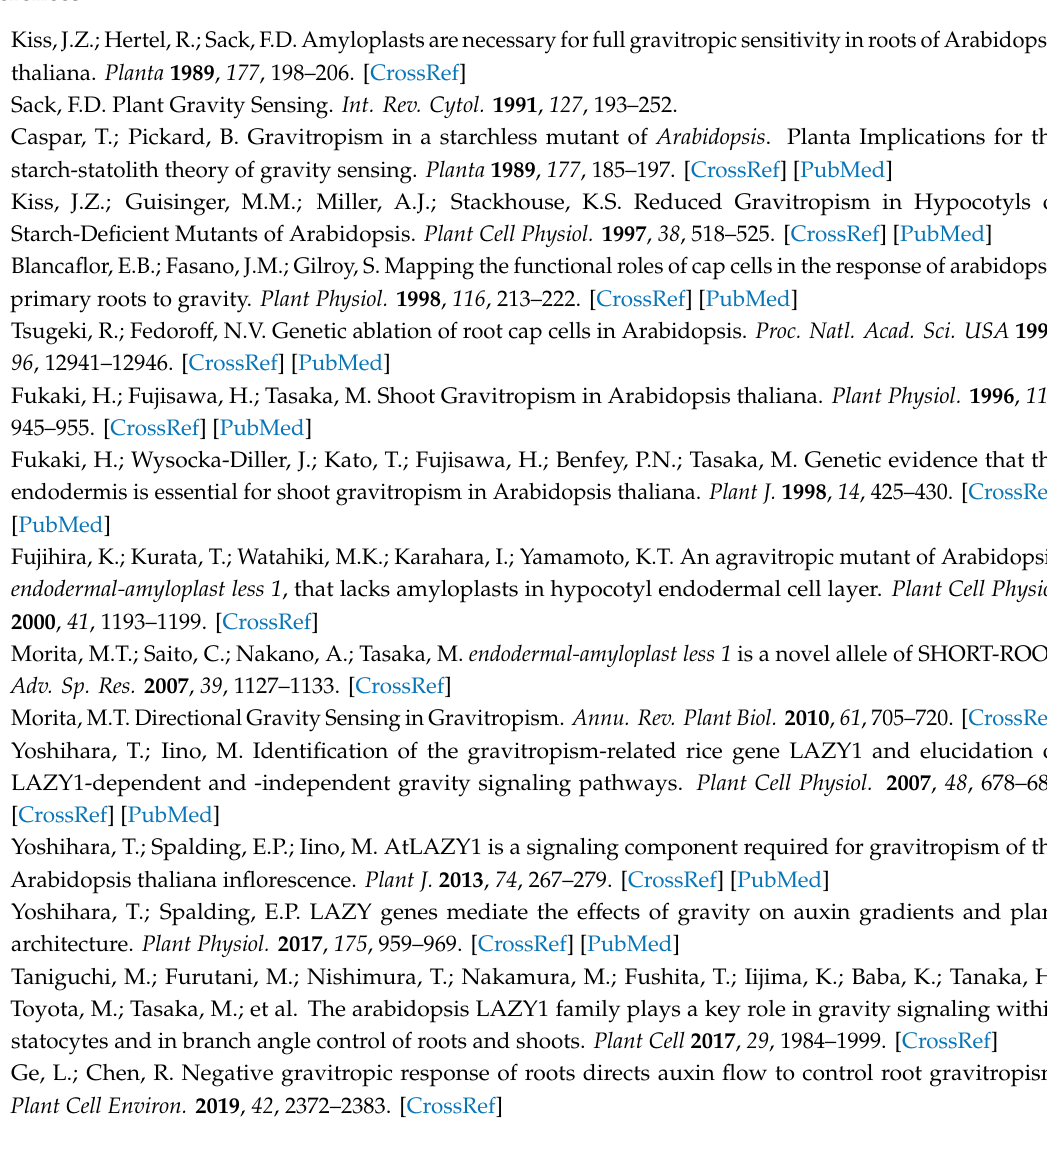
Figure S1: Schematic representation of genetic screening of lzy2;3;4 suppressors. Figure S2: Lugoal’s staining of primary roots from all the sltr candidates. Video S1. Gravitropic response of lateral branch from wild-type Col plant; Video S2. Gravitropic response of lateral branch from lzy1;2;3 plant; Video S3. Gravitropic response of lateral branch from pgm plant; Video S4. Gravitropic response of lateral branch from lzy1;2;3;pgm ; Video S5. Gravitropic response of lateral branch from eal1 plant; Video S6. Gravitropic response of lateral branch from lzy1;2;3;eal1